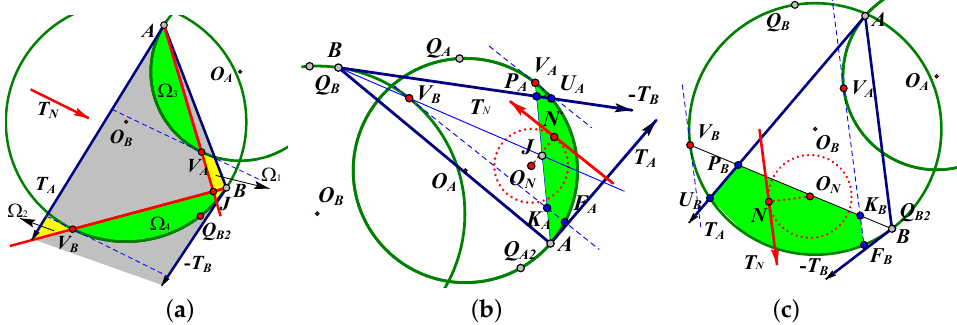
Figure 9. At most one tangent point on each common externally tangent line located inside region G exists. ( a ) α < β ; ( b ) inserting { N , T A , O N } when α > β . ( c ) inserting { N , T A , O N } when α < β